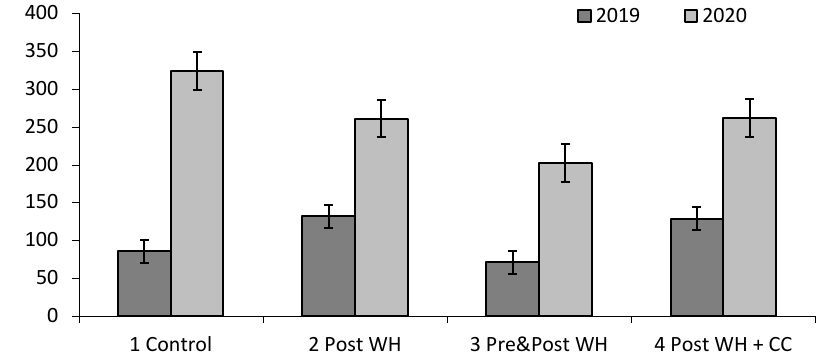
Fig. 2. Number of emerged C. album plants (LSMeans with SEM) at the time of post-